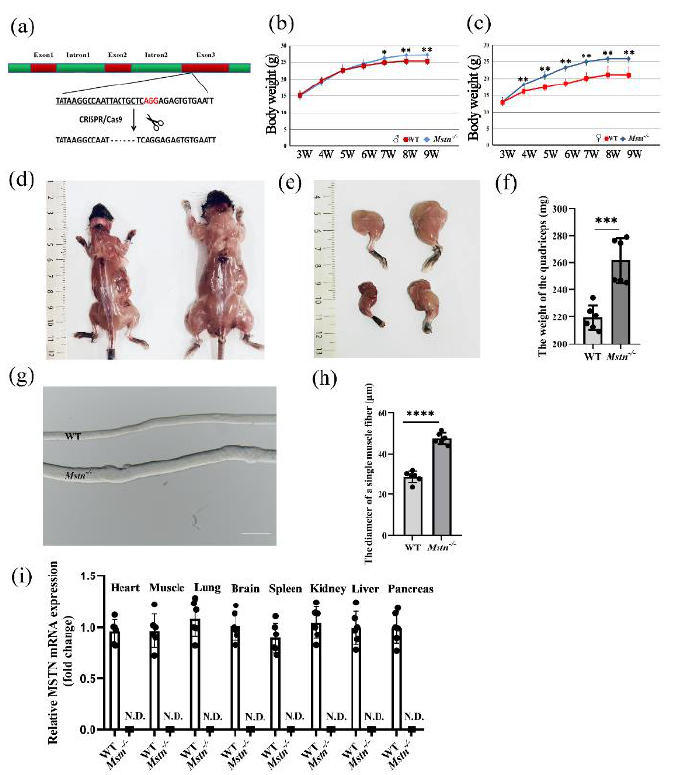
Figure 1. Comparison of muscle morphology and Myostatin (MSTN) expression between wild-type (WT) and MSTN null ( Mstn − / − ) mice. ( a ) Schematic diagram of the gene mutation site. ( b ) Growth- rate comparison for male mice. ( c ) Growth-rate comparison for female mice. ( d ) Morphological appearance of WT (left) and Mstn − / − (right) mice muscles. Scale bars, 1 cm. ( e ) Morphological appearance of forelimbs (bottom) and hindlimbs (top) in WT (left) and Mstn − / − (right) mice. Scale bars, 1 cm. ( f ) Weight for the quadriceps. Each dot presents the quadriceps weight of each mouse. ( g ) Muscle fibers of the quadriceps in WT (top) and Mstn − / − (bottom) mice. Scale bars, 100 µ m. ( h ) Quantitative analysis of muscle fiber diameter. Each dot presents the muscle fiber diameter of each mouse. ( i ) Real-time PCR analyses of Mstn expression in different organs. N.D., not detectable. All the data are presented as mean ± SD. Compared with the control group, * p < 0.05, ** p < 0.01, *** p < 0.001, **** p < 0.0001; Student’s t -tests were used to calculate the p -values. We used n = 6 mice per group. Except where noted, each dot represents a